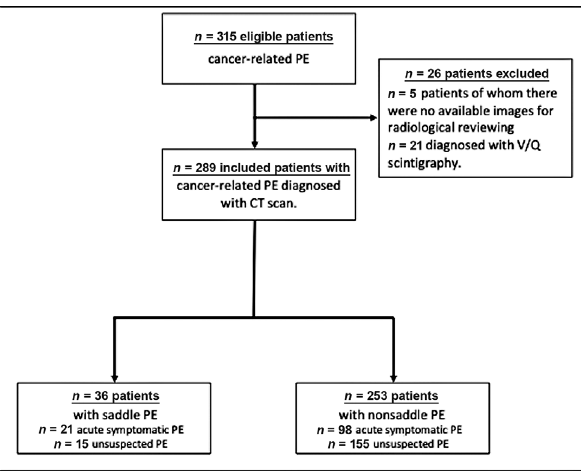
Fig. 2 Flow chart of patient selection for the study. CT, computed tomography; PE, pulmonary embolism.